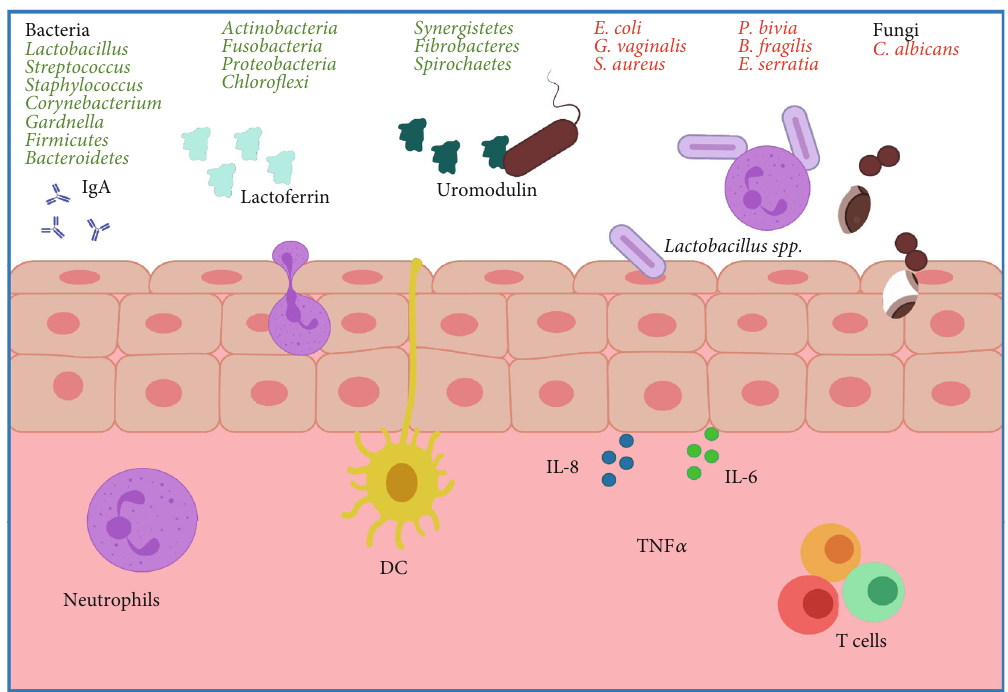
Figure 4: Main components present in the genitourinary microbiota. The main cells of the immune system that are present in the genitourinary mucosa are shown, in addition to relevant molecules such as IgA antibodies and key proteins of a healthy mucosa. Commensal microorganisms of the genitourinary tract are indicated in green and pathogenic microorganisms in